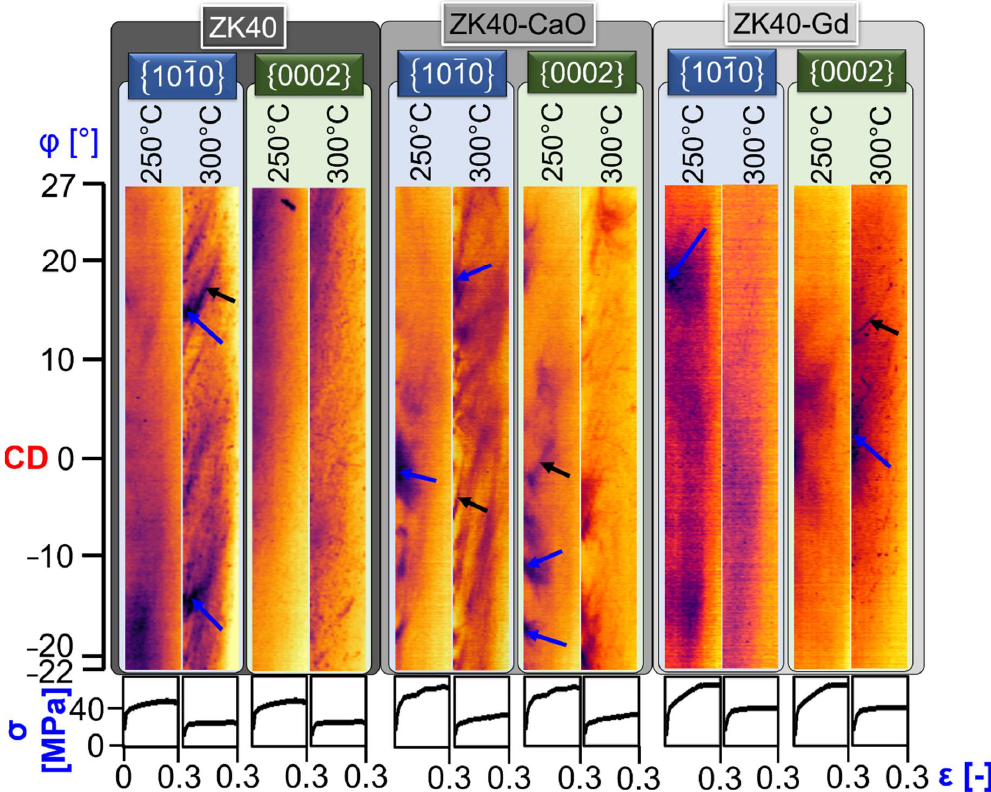
Figure 9: Azimuthal-strain plots for the three investigated alloys tested at 250 °C and 300 °C for the strain rate of 0.001 s −1 . Blue arrows indicate the intense spread of orientation in the diffraction rings strain rate of 0.001 s − 1 . Blue arrows indicate the intense spread of orientation in the di ff raction rings and and the decay in the intensity of the diffraction signal. Black arrows indicate the bending of the the decay in the intensity of the di ff raction signal. Black arrows indicate the bending of the timelines. timelines. CD indicates the compression direction. CD indicates the compression